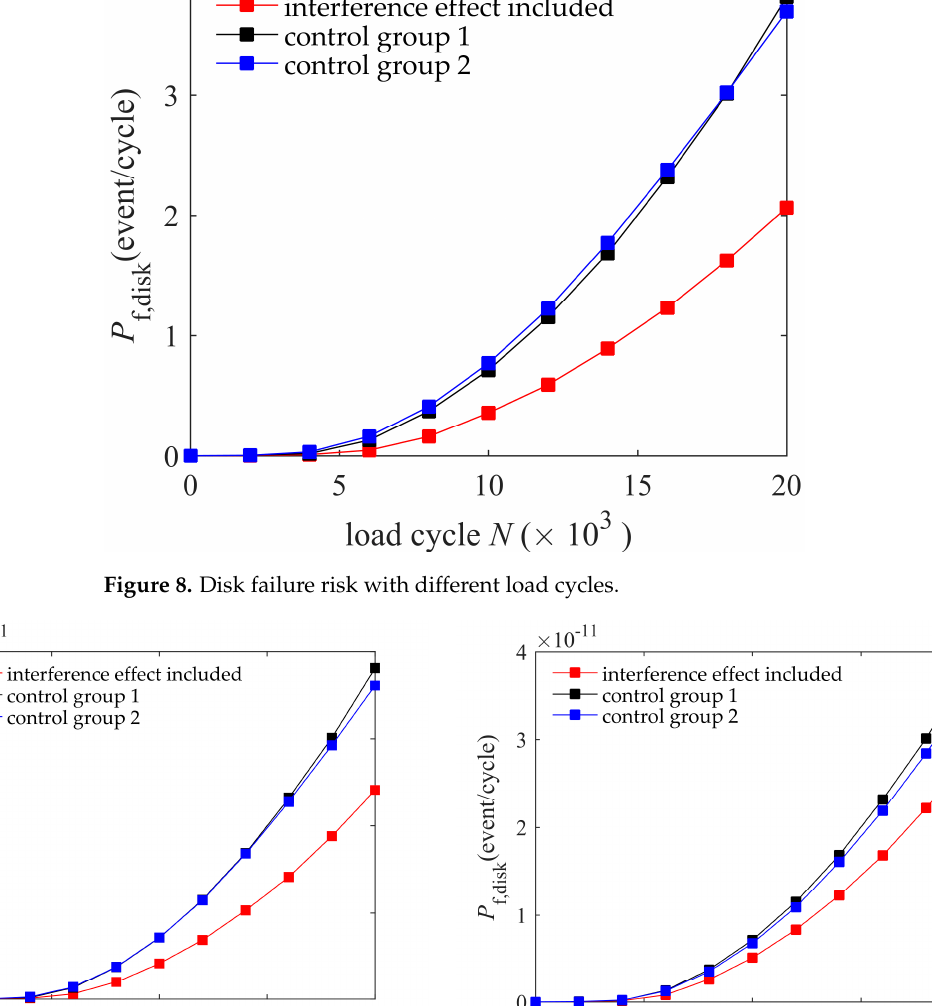
Table 3. Statistical results after repeated calculations by different